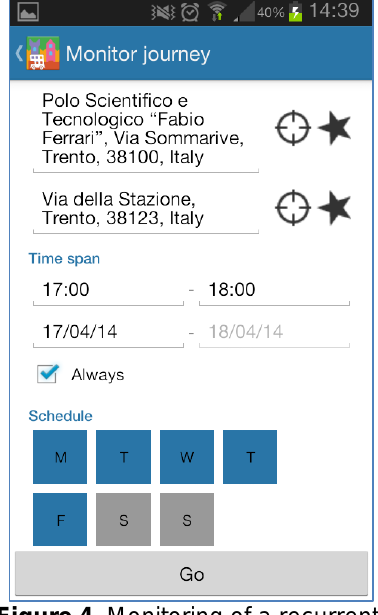
Figure 4. Monitoring of a recurrent trip